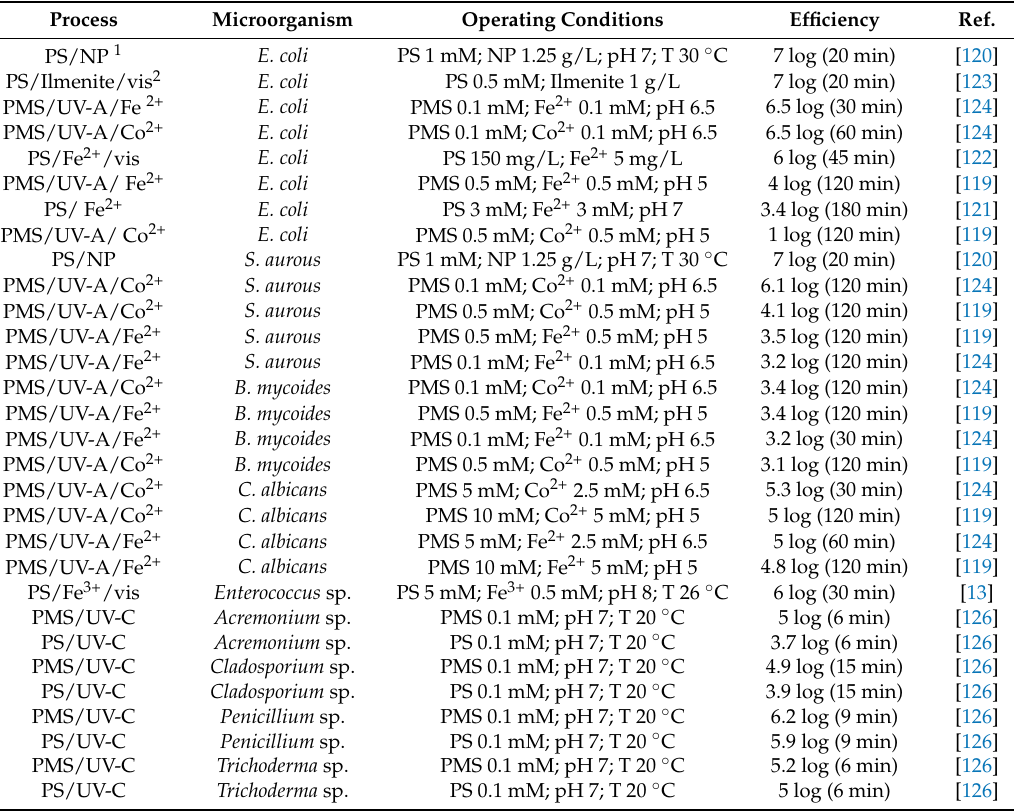
Table 8. Disinfection efficiencies of different sulfate radical-based advanced oxidation processes